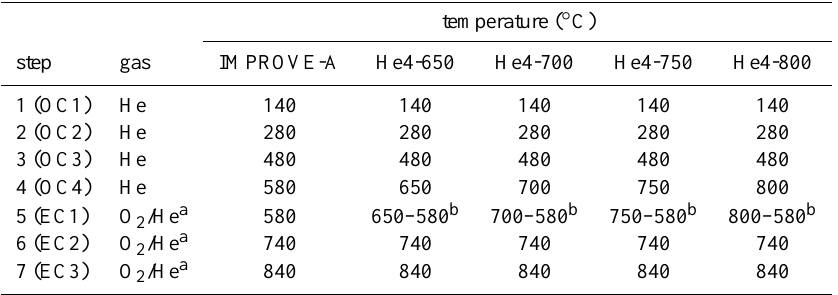
Table 1. Temperature protocols used in the present